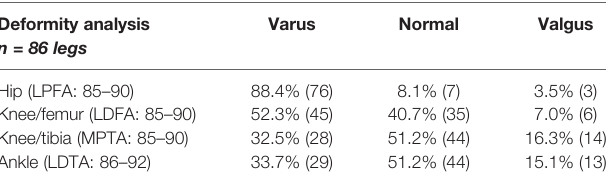
TABLE 2 | Radiographic fi ndings of patients with XLH who presented with varus and valgus deformity at the hip, knee, and